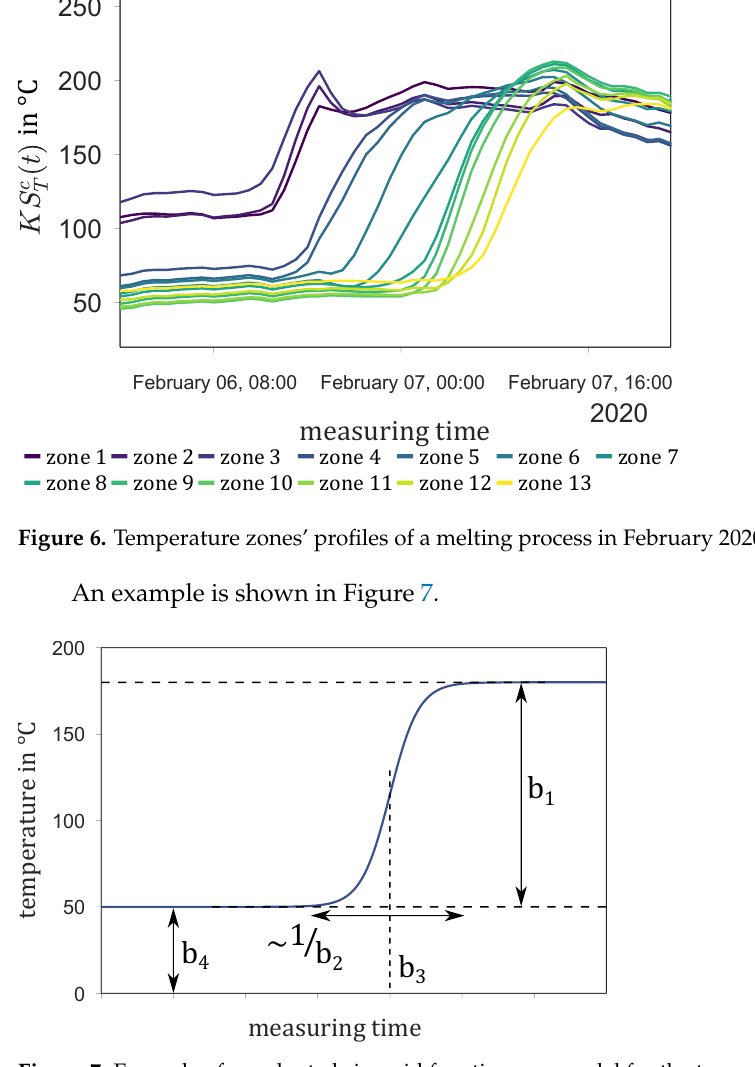
Figure 7. Example of an adapted sigmoid function as a model for the temperature of a zone during a melting